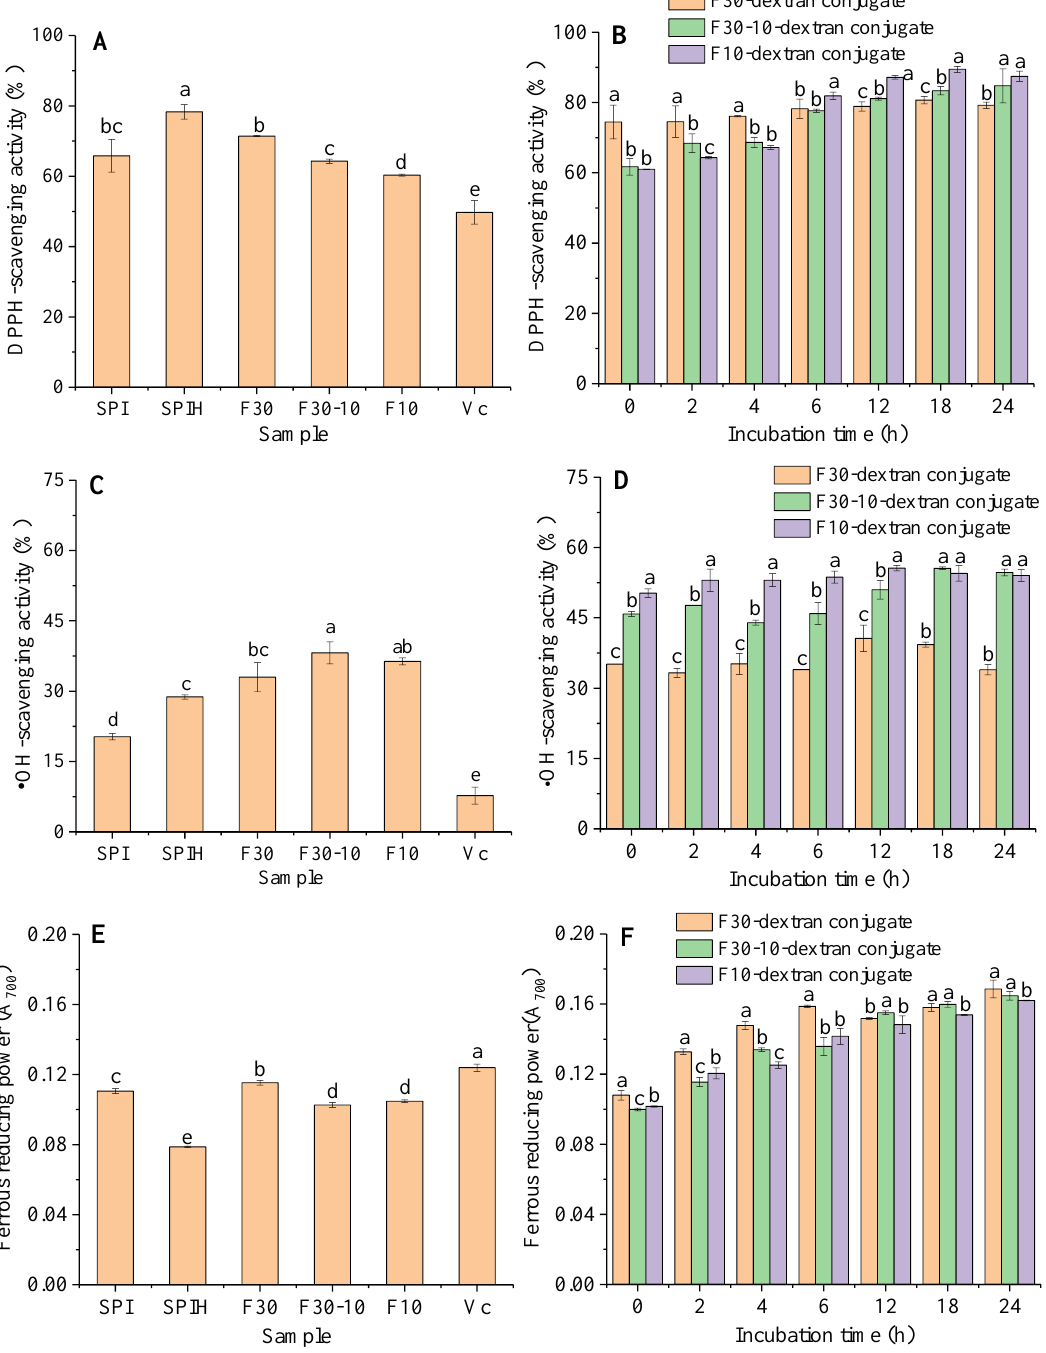
Figure 6. Antioxidant activities of the SPI, SPIH, F30, F30-10, F10, and V C ( A , C , E ) and F30/F30- 10/F10-dextran conjugates ( B , D , F ) incubated for 0, 2, 4, 6, 12, 18, and 24 h. (Different letters for conjugates incubated at the same time represent the significant difference, p < 0.05.) Nevertheless, the DPPH radical scavenging activity of F30, F30-10, and F10 significantly enhanced after glycosylating with dextran (Figure 6B), suggesting that the grafting of dextran improved the antioxidant activities of SPIH. A similar result was also reported when neutrase-based SPIH was glycosylated with maltodextrin using a wet- heating method [19]. In addition, the DPPH radical scavenging activity of F30/F30-10/F10-